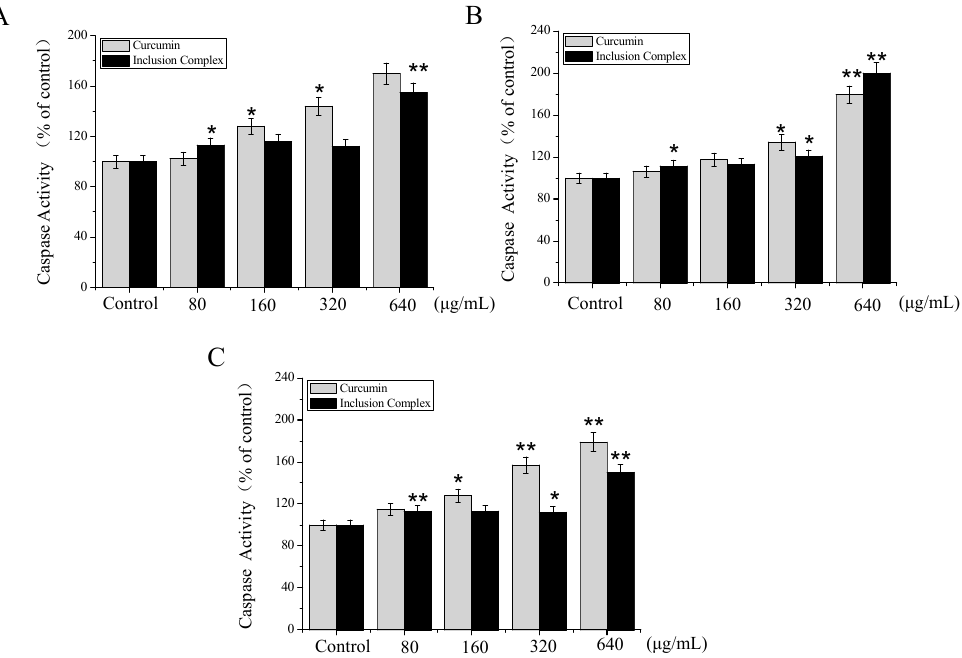
Figure 9. Effects of inclusion complex on caspase activities of caspase 3 ( A ), caspase 8 ( B ), and caspase 9 ( C ) in A375 cells. Caspase activities as measured by specific fluorescent substrates for caspase-3/8/9. Cells were pretreated with different concentrations of inclusion complex or curcumin for 72 h, respectively. Significant difference between treatment groups and control groups is indicated at p < 0.05 (*) or p < 0.01 (**) level.